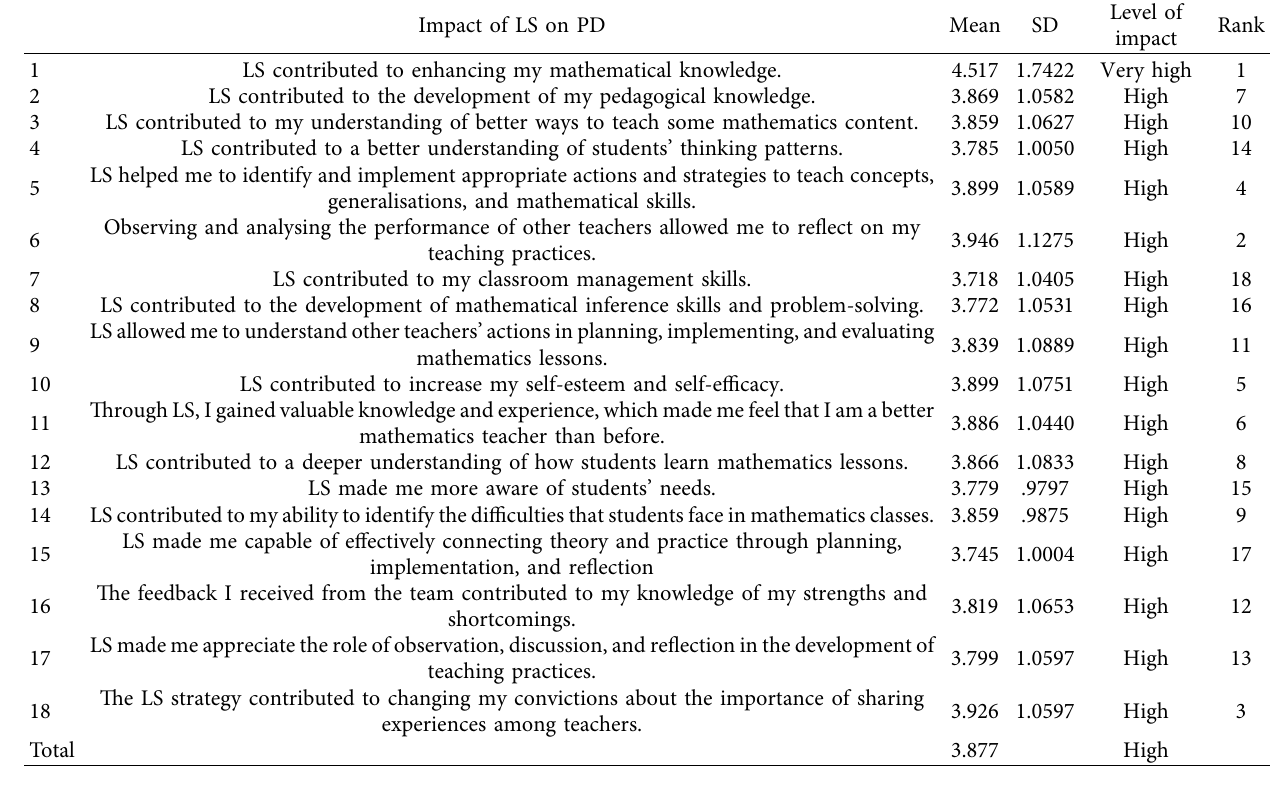
Table 4: Teachers’ perspectives about the impact of lesson study (LS) on their professional development